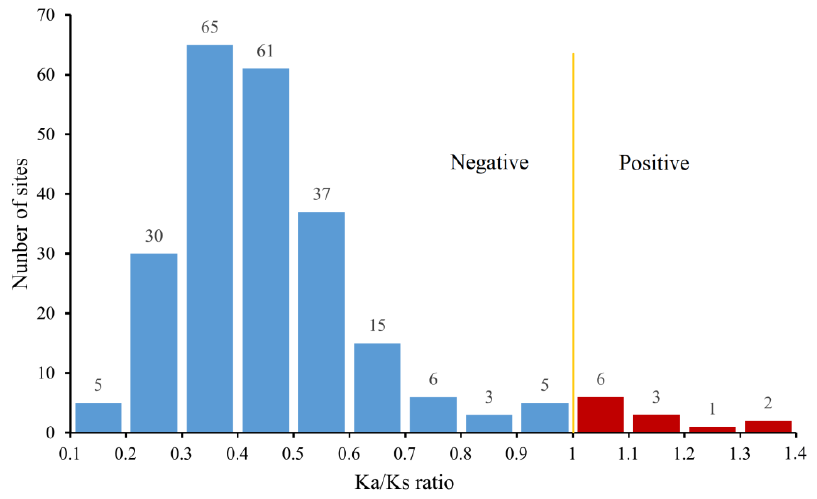
Figure 5. Collinearity relationship of OR genes in S. sihama and L. crocea. Orange bars represent the S. sihama chromosome. Green bars represent the L. crocea chromosome. The grey lines represent the collinearity relationship between S. sihama and L. crocea genes. The red lines represent the collinear- ity relationship between S. sihama and L. crocea OR genes.